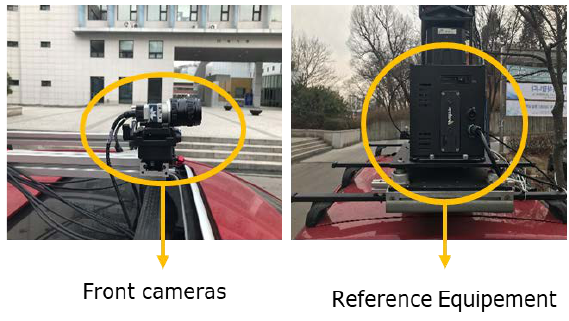
Figure 3. The data acquisition system